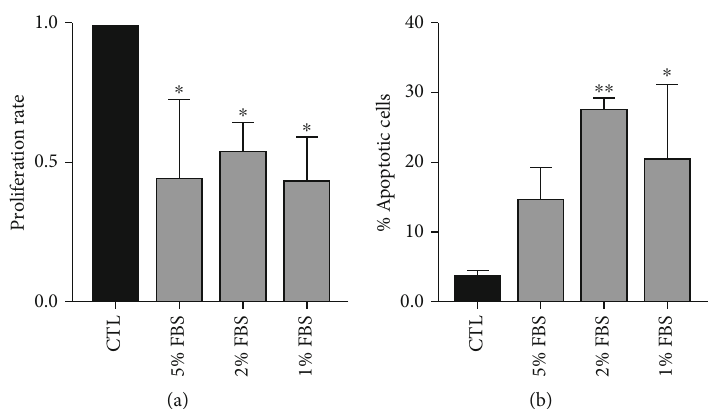
Figure 3: Damage setting by serum deprivation of HCECs. (a) Proliferation levels at di ff erent concentration of FBS (5-1%) of HCECs after 24h of treatment. Data are represented as mean ± SD of three independent experiments normalized to CTL. (b) Percentage of apoptotic HCECs at di ff erent concentration of FBS (5-1%) of HCECs after 24 h of treatment. Data are represented as mean ± SD of three independent experiments normalized to CTL. One-way ANOVA analysis with Tukey ’ s multicomparison tests was performed among FBS and CTL ( ∗ p < 0 : 05 , ∗∗ p < 0 : 001 ).